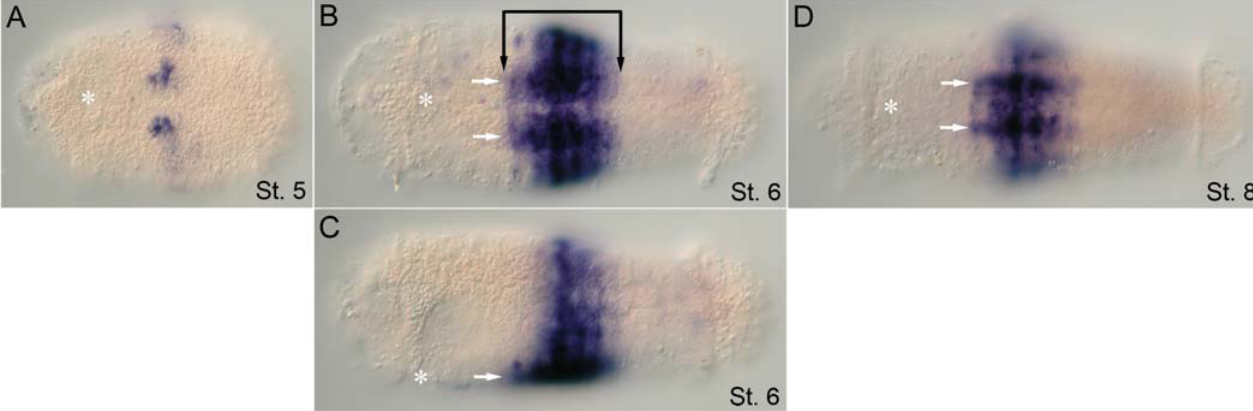
Figure 7. Expression patterns of CapI-Scr during larval stages. Anterior is to the left for all panels. Stages are indicated at bottom right of each panel. (A), (B), and (D) show ventral views; (C), lateral view. Asterisk marks position of the mouth. (A) Initiation of CapI-Scr expression at late stage 4 straddling the midline in T3 and T4 with weaker ventro-lateral expression in these segments. (B, C) Expression is in the VNC (white arrows) and lateral ectoderm in segments T3 to T7 (bracket). (D) Expression at stage 8 is very similar to the pattern at stage 6 (compare with